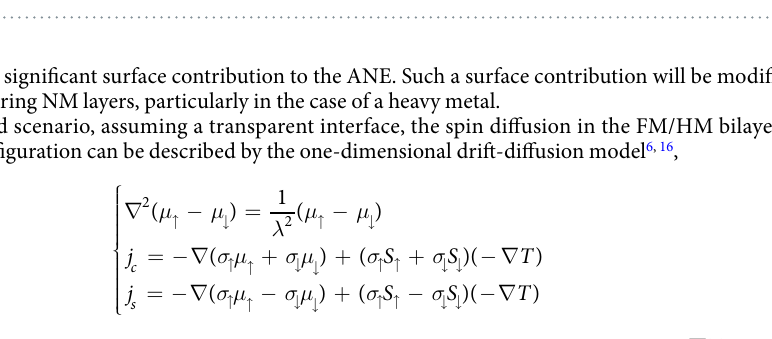
Figure 1. ( a ) Illustration of transverse and longitudinal configurations for detecting the spin Seebeck effect. ( b ) Power dependence of measured anomalous Nernst signal for different thicknesses of Ni 7 Fe 93